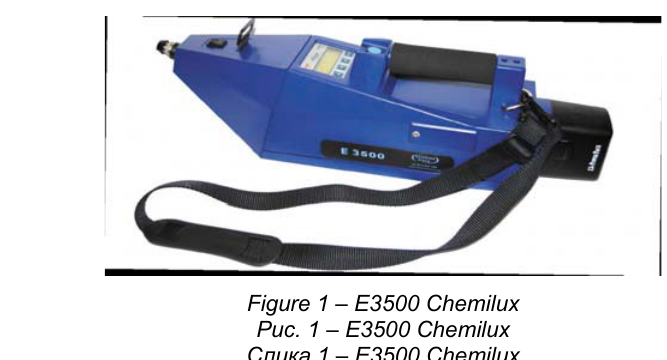
Figure 1 – Е 3500 Chemilux Рис . 1 – Е 3500 Chemilux Слика 1 – Е 3500 Chemilux